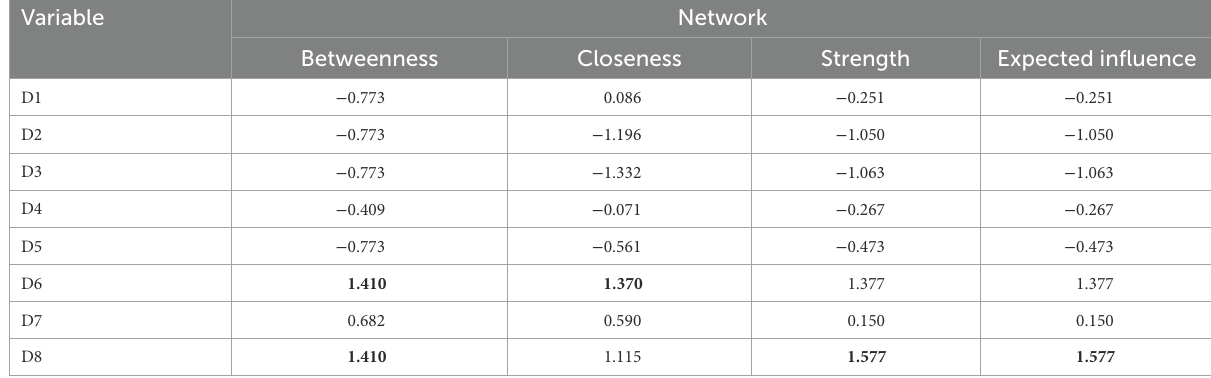
The highest values were bolded and discussed in text.